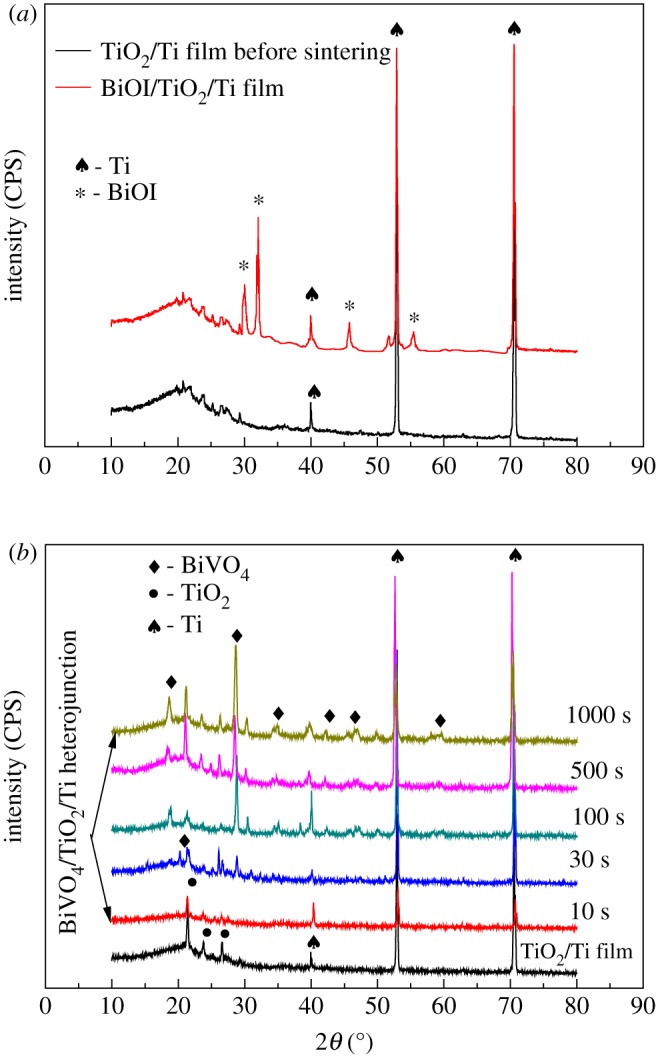
XRD patterns: (a) TiO2/Ti before sintering and BiOI/TiO2/Ti with 1000 s electrodeposition time; (b) sintered nanoporous TiO2/Ti film and BiVO4/TiO2/Ti heterojunction films prepared with different electrodeposition times.